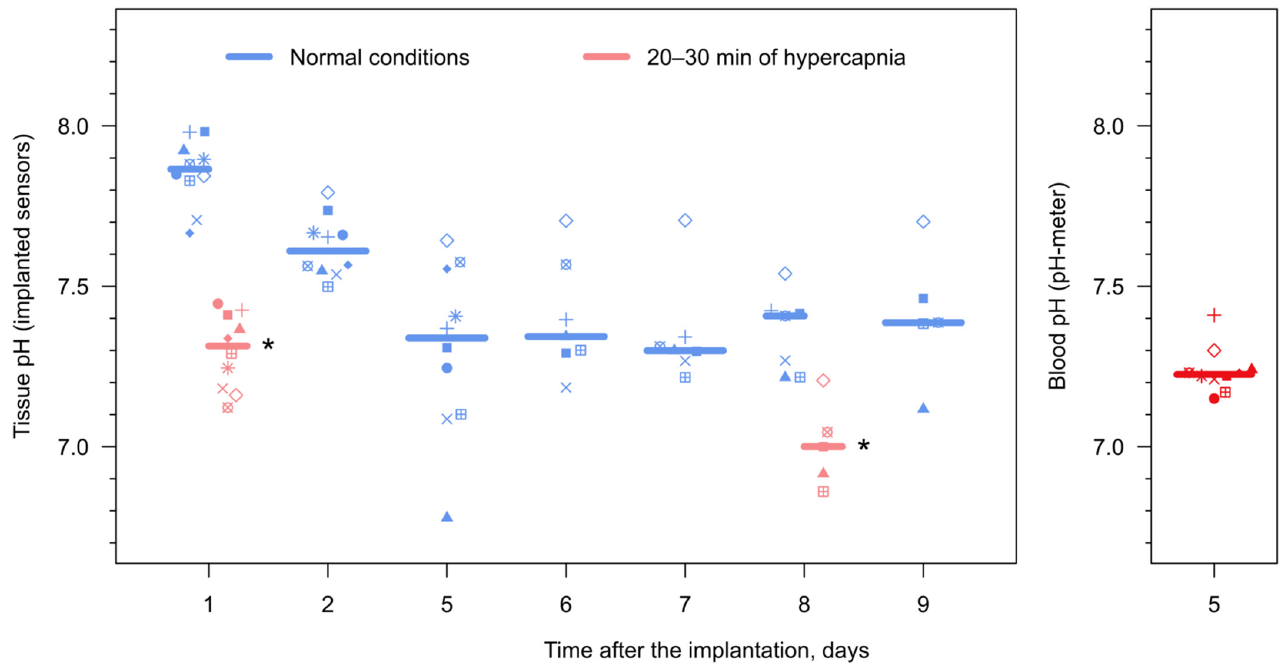
Figure 5. Monitoring tissue pH in the adipose fin of rainbow trout using the implanted sensors in vivo. Each symbol indicates an individual animal, and horizontal lines indicate medians. On days 1 and 8 after implanting the sensors, the animals were subjected to elevated CO 2 concentration (55–60 mg/L) for 20–30 min right after the measurements in normal conditions. Asterisks indicate statistically significant differences from the pH measurements right before the hypercapnic exposures with p < 0.01. Additionally, on day 5, the blood pH was measured right after acquiring the optical signal from the implanted sensors in order to compare the values.